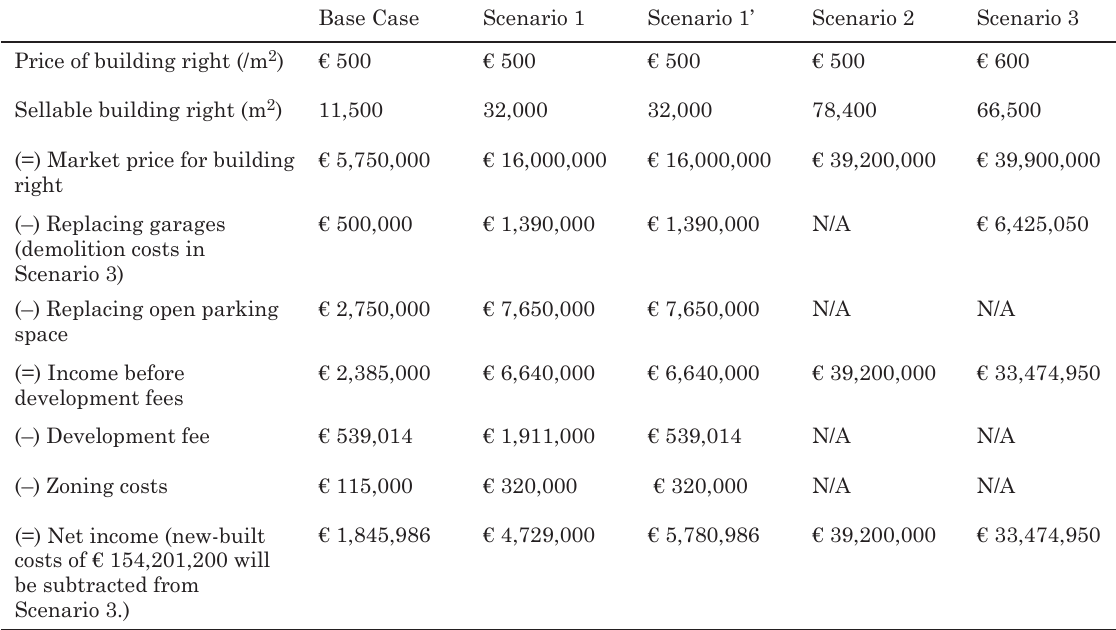
table 3. equity option